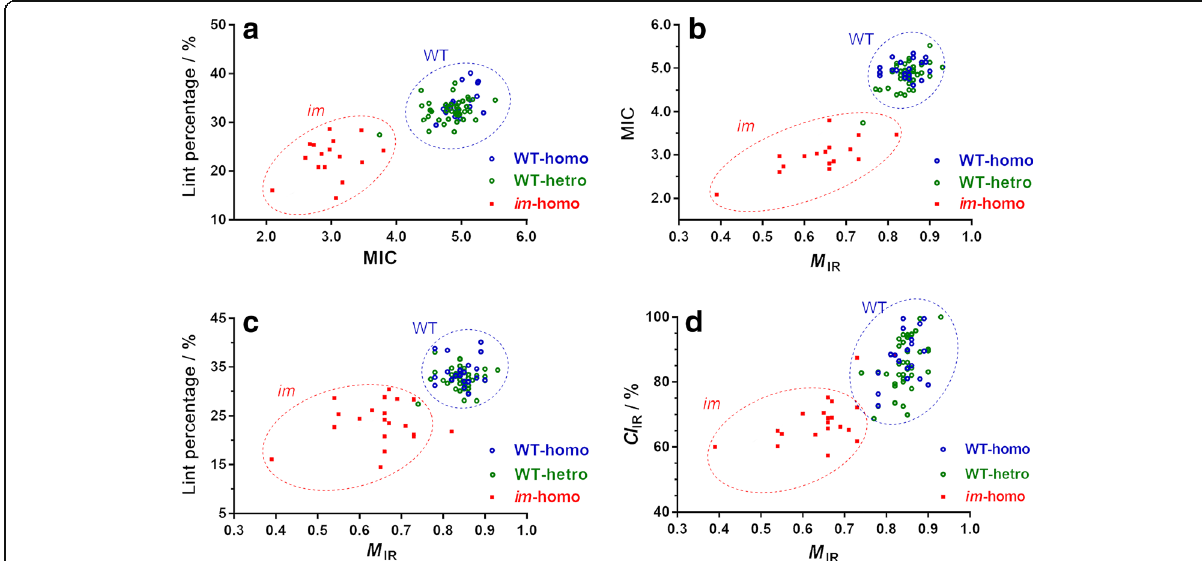
Fig. 7 Classification of im and WT phenotypes by a combination of two phenotypes. Comparisons of the genotypes with a combination of MIC and lint percentage phenotypes ( a ), M IR and MIC phenotypes ( b ), M IR and lint percentage phenotypes ( c ) and M IR and CI IR phenotypes ( d ). CI IR , IR crystallinity; MIC, micronaire; M IR , IR maturity